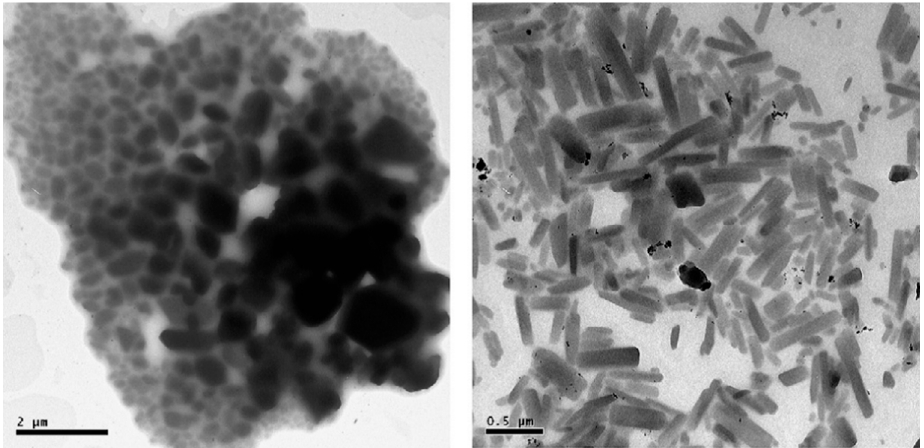
Figure 2. TEM images of poloxamer F127 stabilized indomethacin ( left ) and itraconazole ( right ) nanosuspensions. Nanocrystals are produced by milling (reprinted from [25] with permission. Copyright Elsevier 2011).